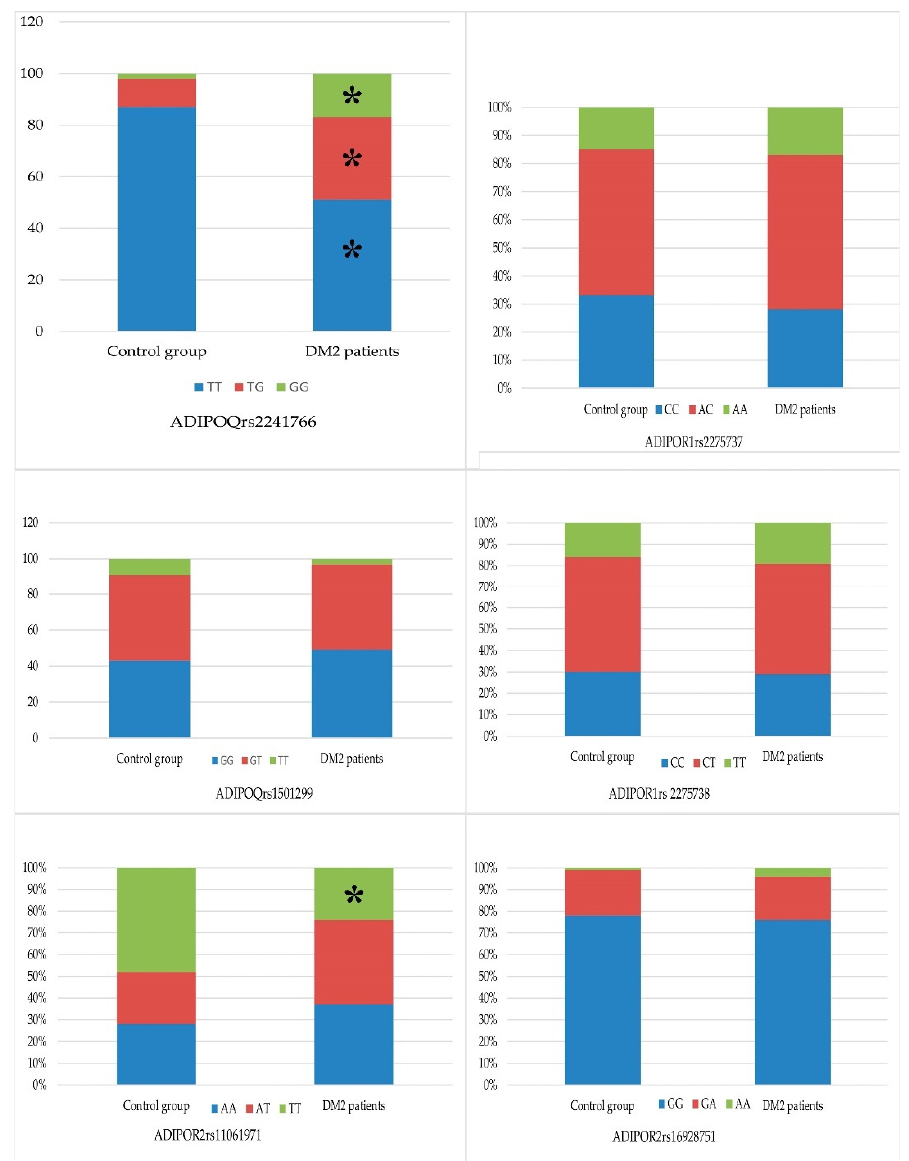
Figure 1. Distribution of genotype polymorphism’s alleles in patients with diabetes mellitus in comparison with healthy individuals . Notes: the symbols of genotypes are given in the graphs , *— p -value < 0.05.